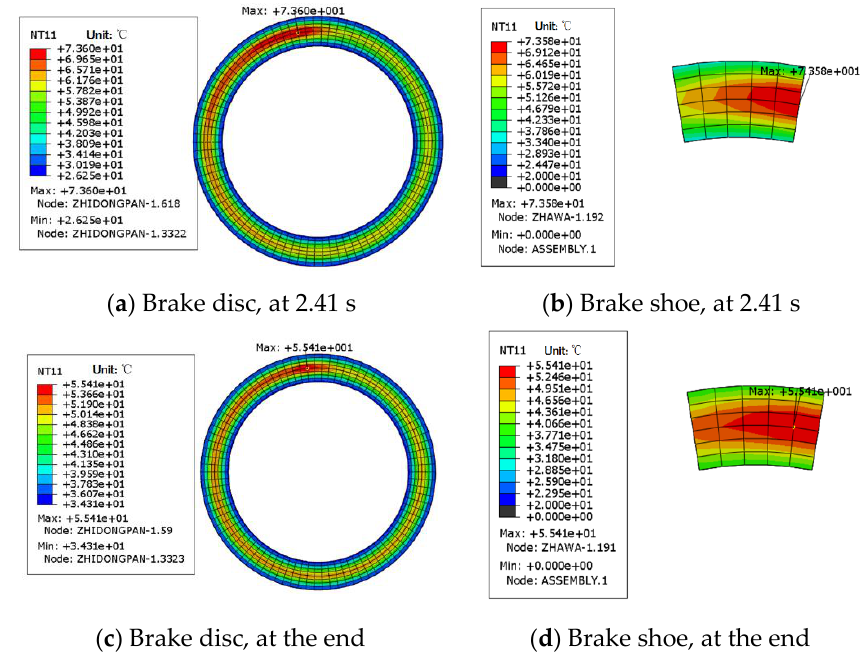
Figure 4. Temperature distributions at contact surfaces of brake disc and brake shoe during emergency braking (counterclockwise rotation of brake disc).